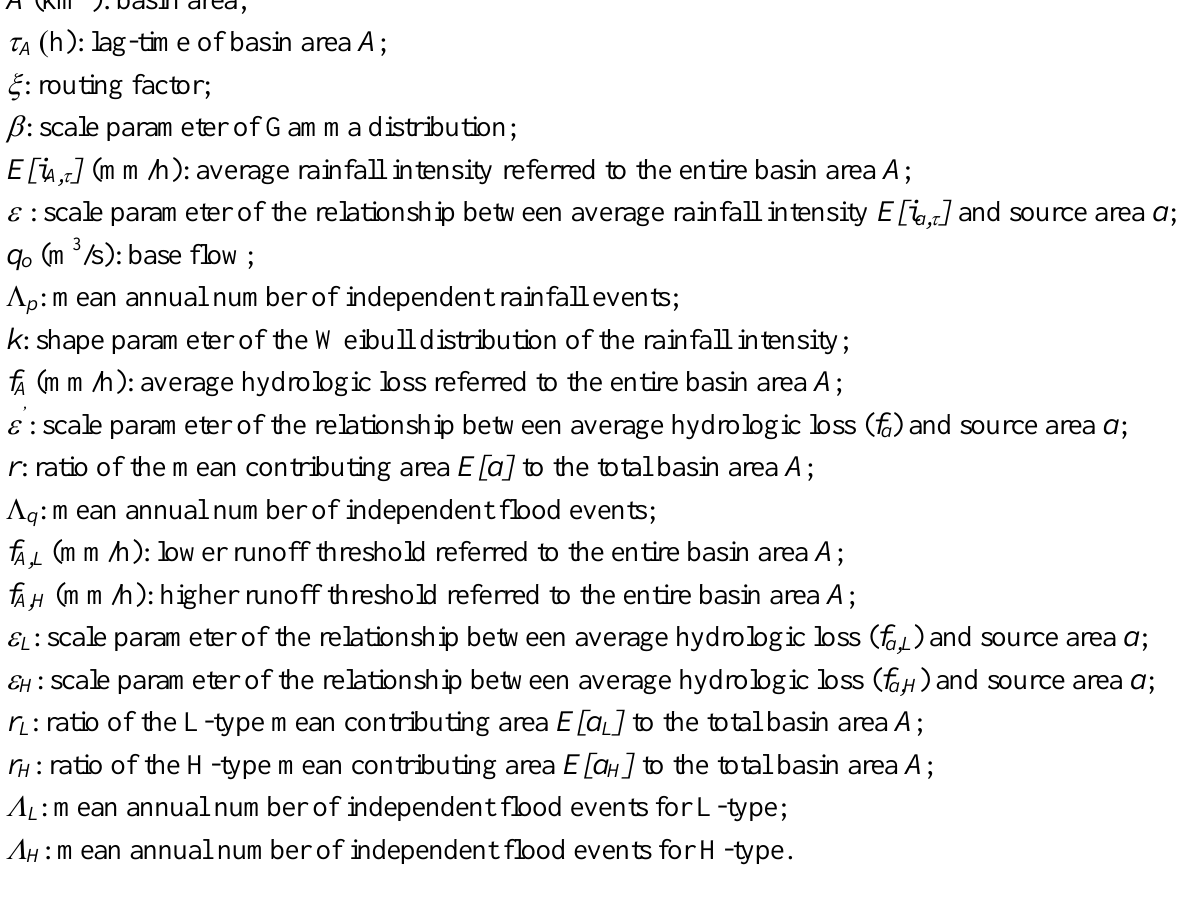
List of Model Parameters, Units (Parameters without Units are Dimensionless), and Short